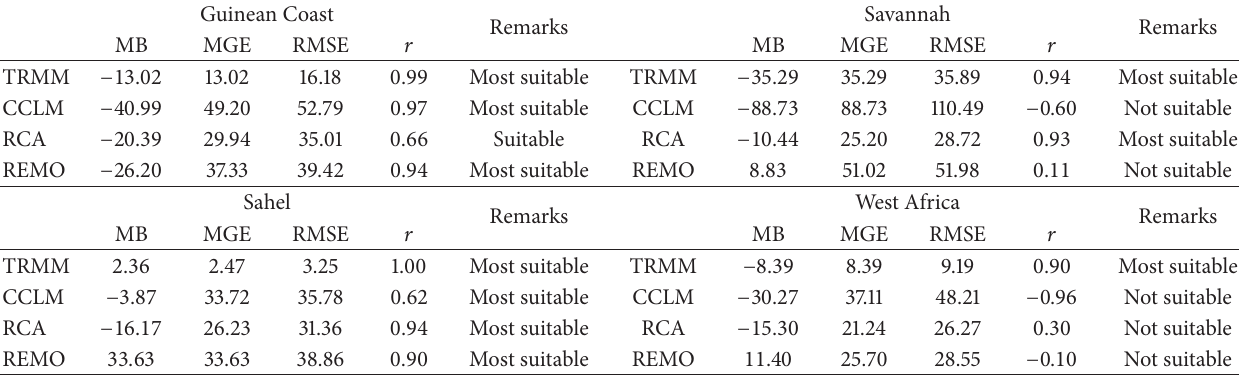
Table 1: Detailed output of the statistical analysis of the satellite and the CORDEX